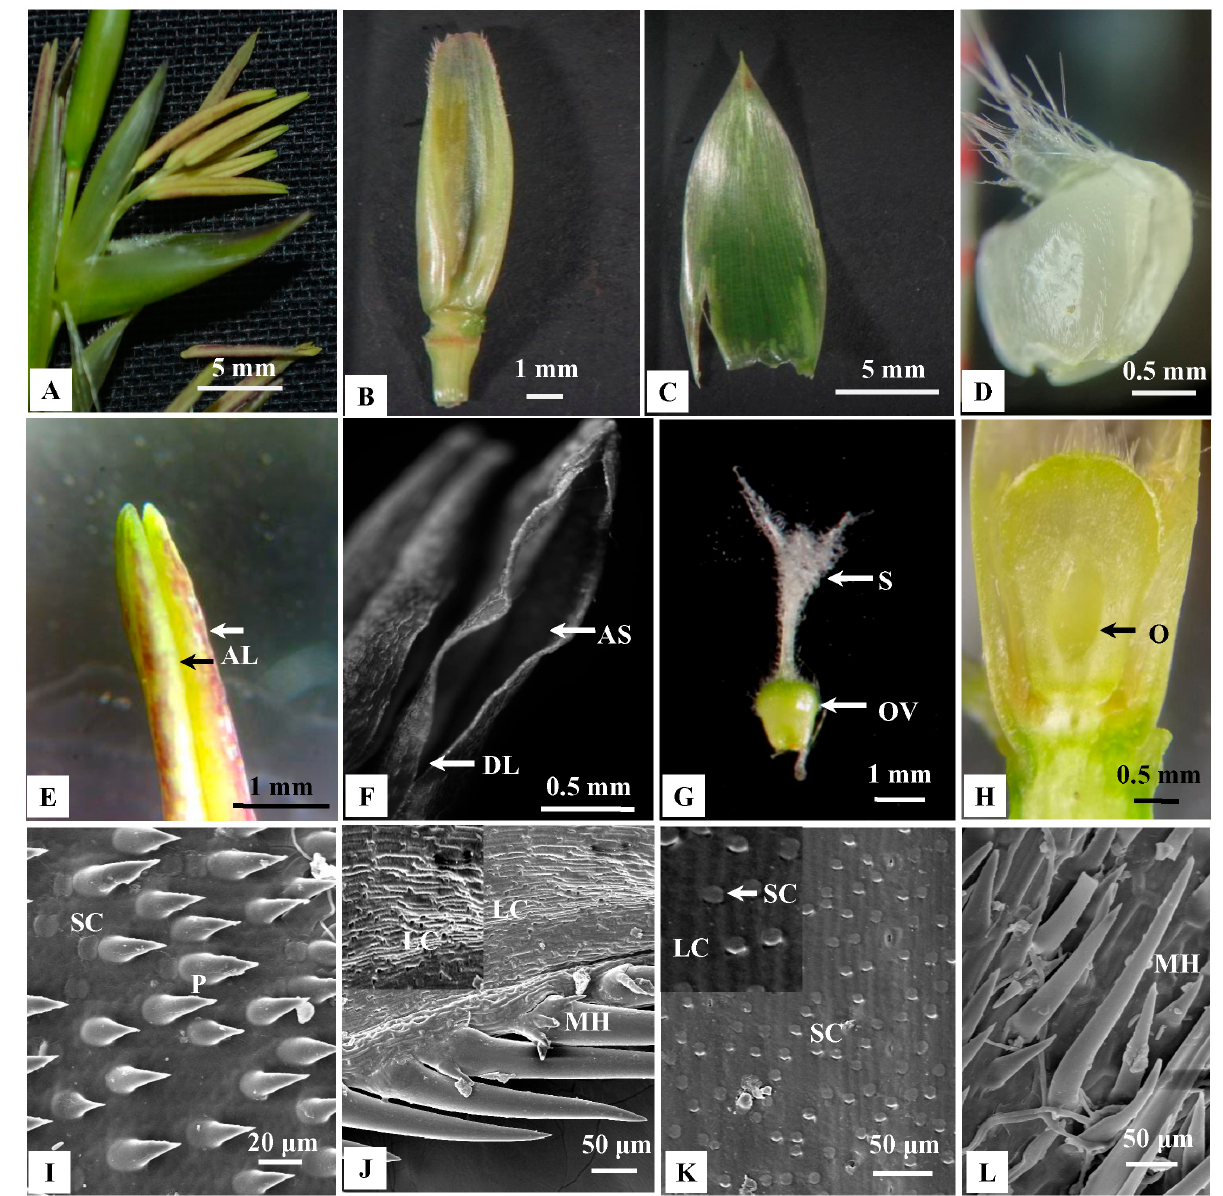
Figure 4. Morphological observation of different floral parts of B. tulda and Scanning electron microscope (SEM) images of the abaxial epidermis of palea and lemma; ( A ) Single floret with six basifixed anthers. ( B ) Dorsal view of a lemma. ( C ) Dorsal view of a palea. ( D ) Lodicule. ( E ) Anther showing two lobes. ( F ) Apical suture of the anther. ( G ) Gynoecium with trifid stigma. ( H ) Longitudinal section of ovary. ( I ) Presence of prickles (P) and silica cells (SC). ( J ) Presence of macro hair (MH) and long cells (LC; magnified view inset). ( K ) Presence of SC and LC, (LC; magnified view inset). ( L ) Presence of macro hairs (MH). Abbreviations used: F—Floret, G—Glume, AL—Anther lobes, AS—Apical suture, DL—Dehiscence